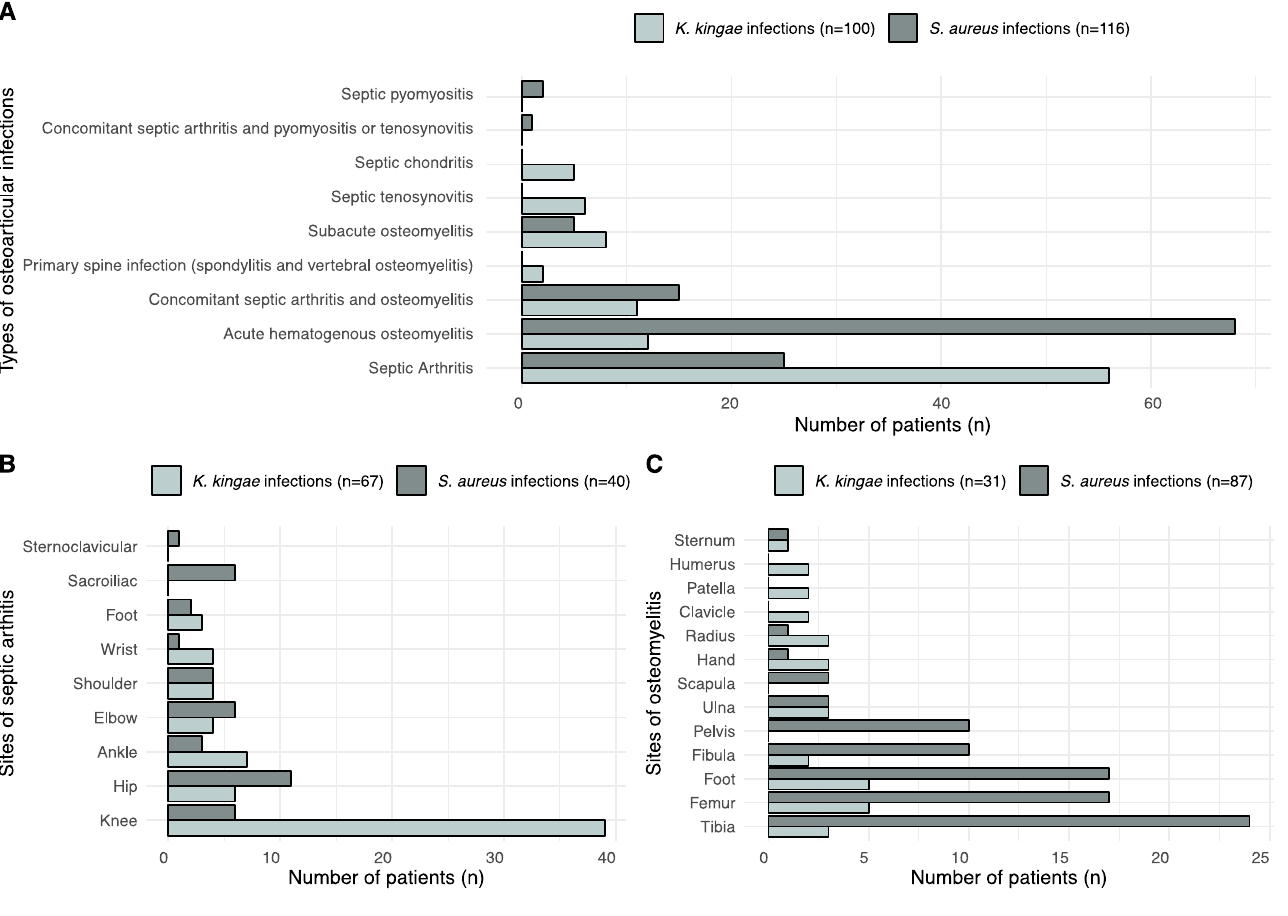
Figure 2. ( A ) Types of infection caused by S. aureus and K. kingae . We noticed that S. aureus mostly caused acute hematogenous osteomyelitis, whereas K. kingae caused arthritis. ( B ) Comparison between arthritis sites of K. kingae and S. aureus infections. We observed that most K. kingae arthritis sites involved the knee. S. aureus had a more balanced distribution. ( C ) Comparison between osteomyelitis sites of K. kingae and S. aureus infections. S. aureus osteomyelitis mostly affected the tibia and the lower limbs in general.